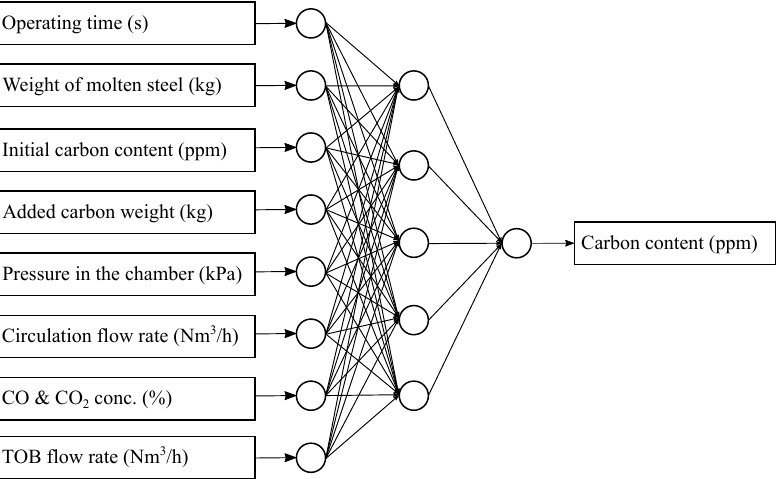
Figure 2. Input and output parameters of the ANN model. The target carbon contents are the result of the decarburization curve. The unit of the carbon content is parts per million (ppm), which means the weight fraction of carbon in molten